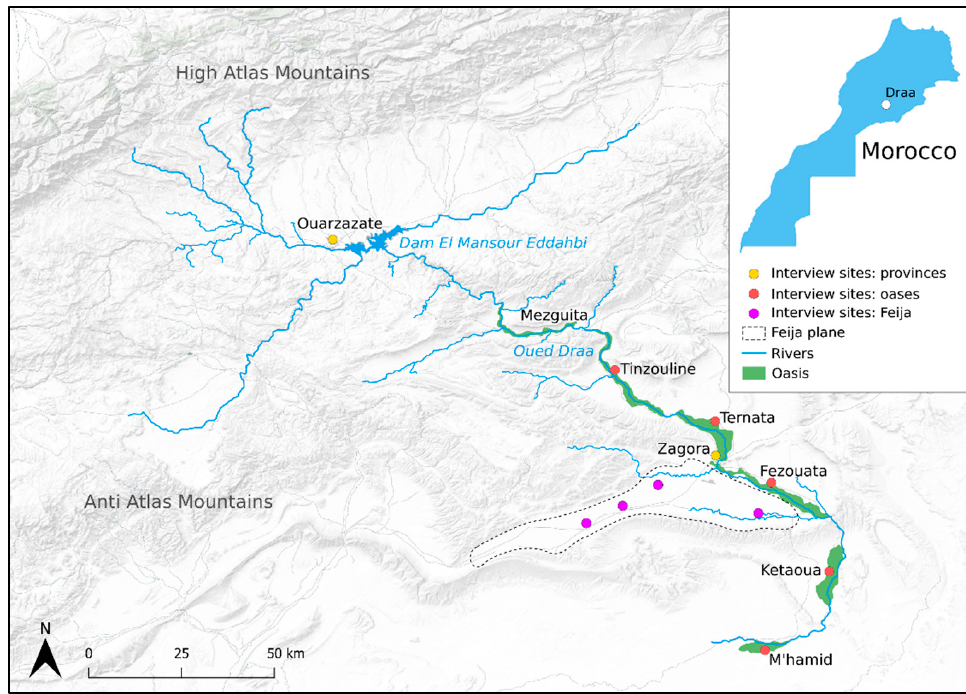
Figure 1. Location of Middle Draa Valley .